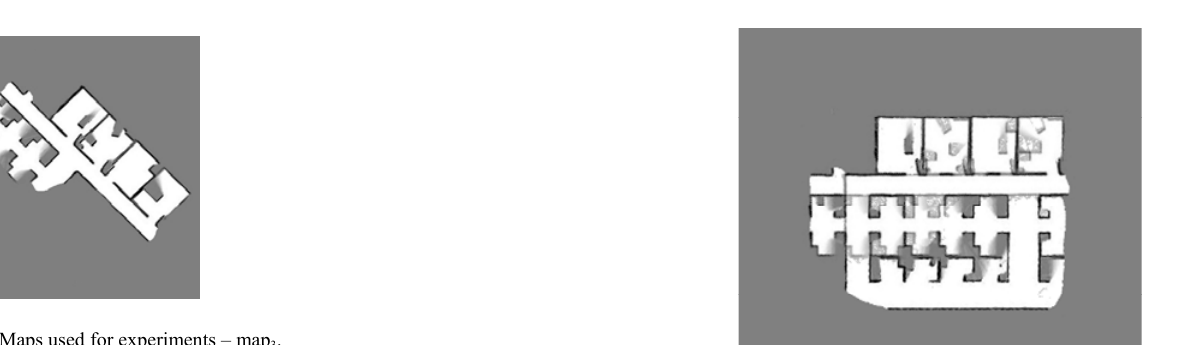
Fig. 3. Maps used for experiments – map 3 .